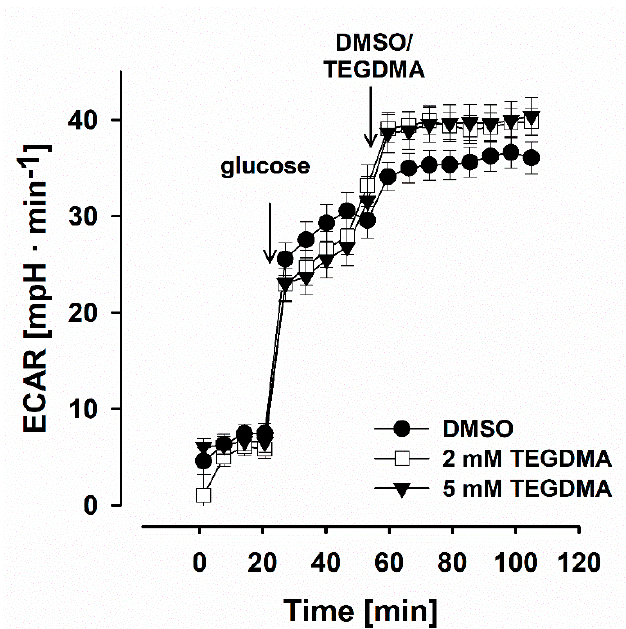
Figure 4. Effect of TEGDMA on extracellular acidification rate (ECAR) of dental pulp stem cells in the presence of glucose. Glucose (10 mM), TEGDMA (2 or 5 mM) or DMSO were injected as indicated. Each symbol represents different concentrations of TEGDMA. Data are expressed as [mpH·min -1 ]. Each point shows mean values of 28–39 parallel wells ± SEM. No significant differences were observed between groups.